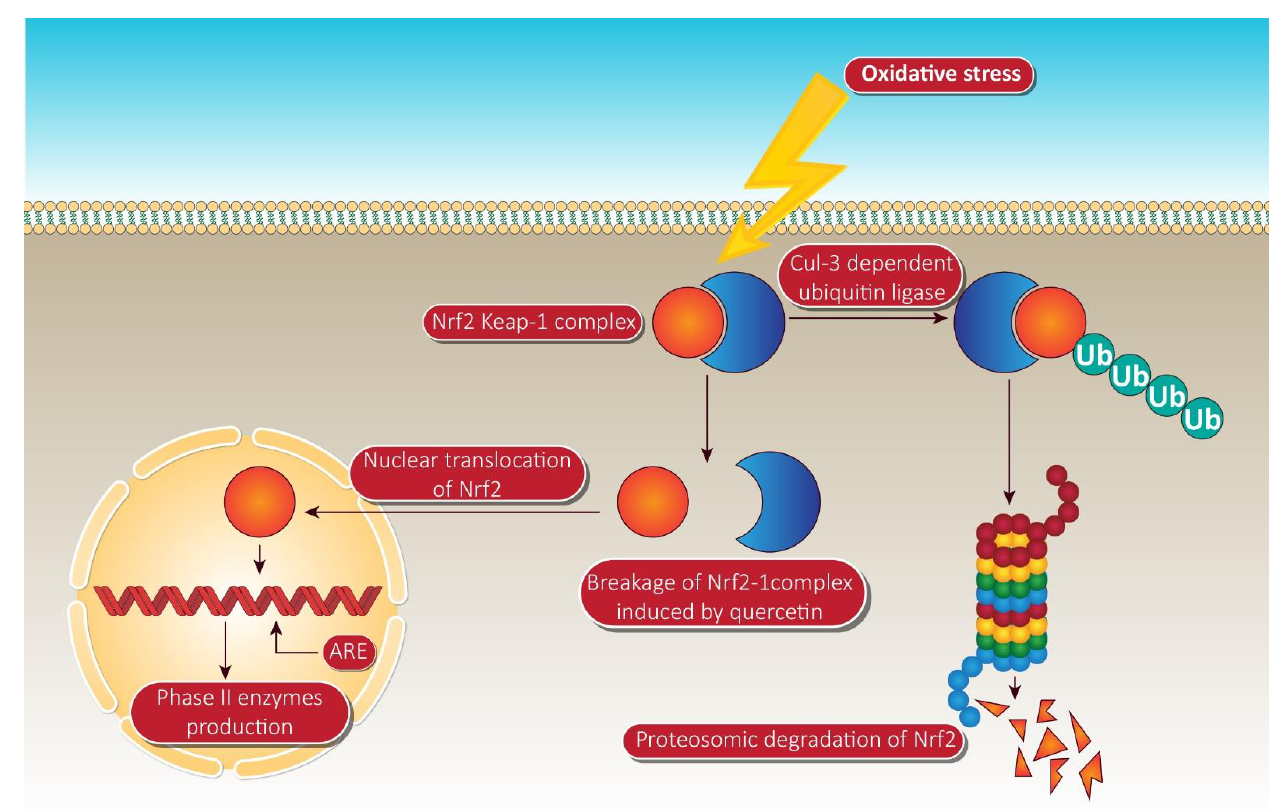
Figure 4. Quercetin targeting via phase II enzyme pathway mediated through Nrf-2. When the cells are unstimulated under stress conditions, Keap-1 isolates Nrf-2 and exposes it to cul-e dependent ubiquitin ligase. This enzyme leads to the proteasomal cleavage of Nrf-2. In the meantime, quercetin degrades the Nrf-2 keap-1 complex and shifts the Nrf2 to the nucleus. Inside the nucleus, Nrf-2 binds to ARE, resulting in the production of phase II enzymes via Nrf-2 associated expression. NrF-2, nuclear factor erythroid 2 related factor-2; Ub, ubiquitin; ARE, anti-oxidant response element. Human colorectal adenocarcinoma cells and duodenal adenocarcinoma HuTu 80 cells were further identified as receiving a quercetin triggered boost in phase II oxidative stress (detoxification enzymes). Additionally, the time-dependent influence of quercetin on the transcriptional regulation of Nrf2 and its increased mRNA and protein expression was consistently observed in HepG2 and malignant mesothelioma cells [125].